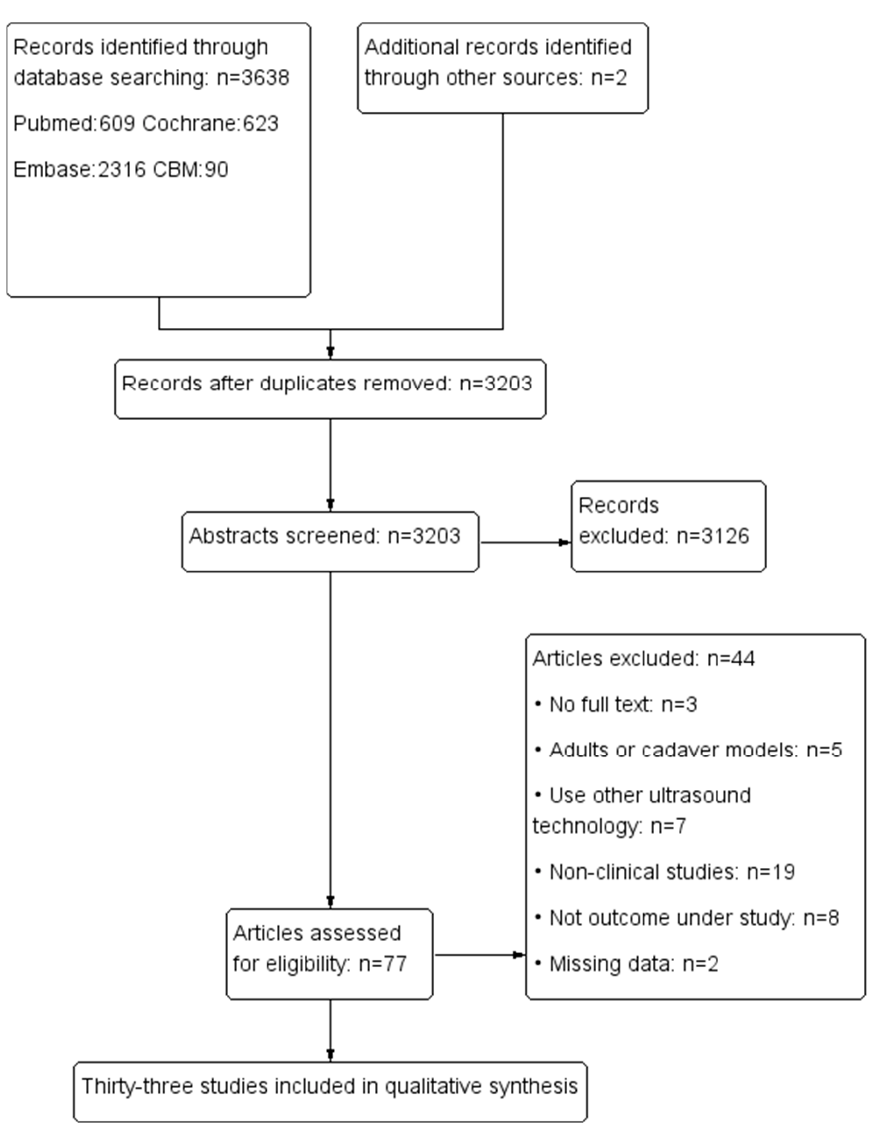
Figure 1. Flow chart of the literature search.